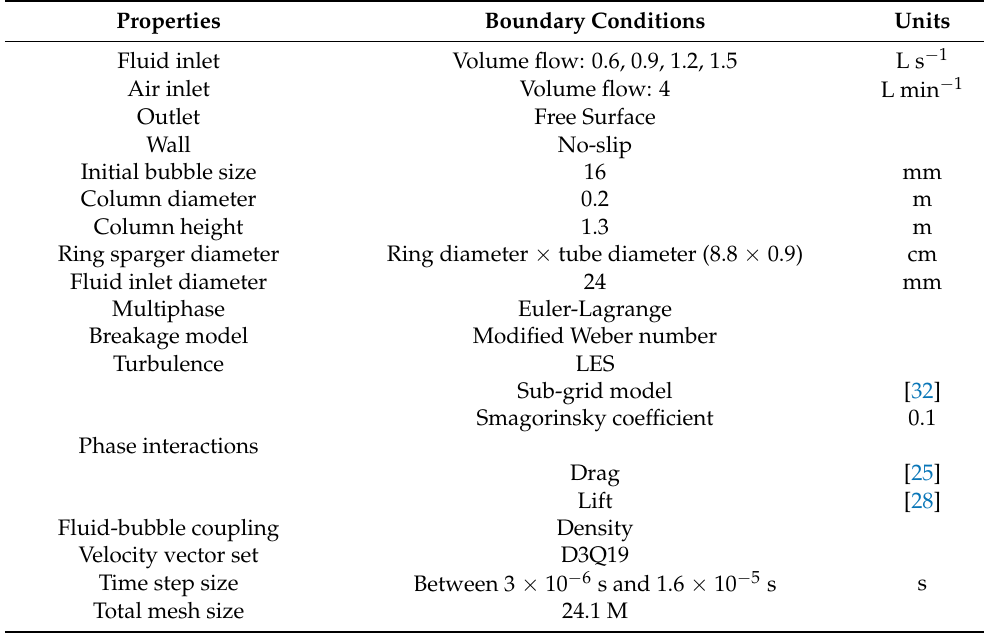
Table 2. Geometry, simulation set-up, boundary conditions and solver setting of bubble column simulation in